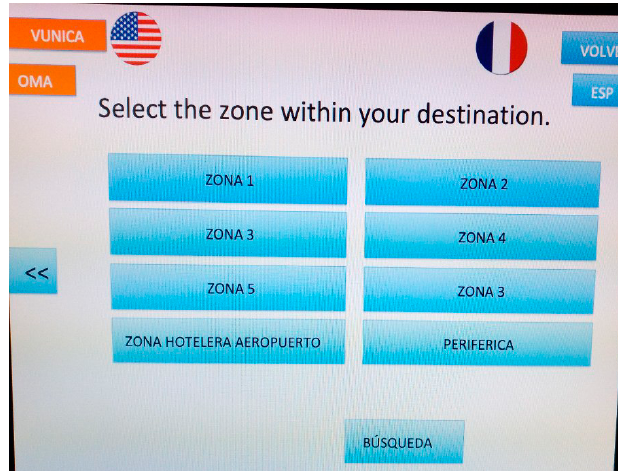
Figure 23. Kiosk vending machine and interface for taxi tickets at the Monterrey airport. The screen shows some texts in English and some in Spanish.